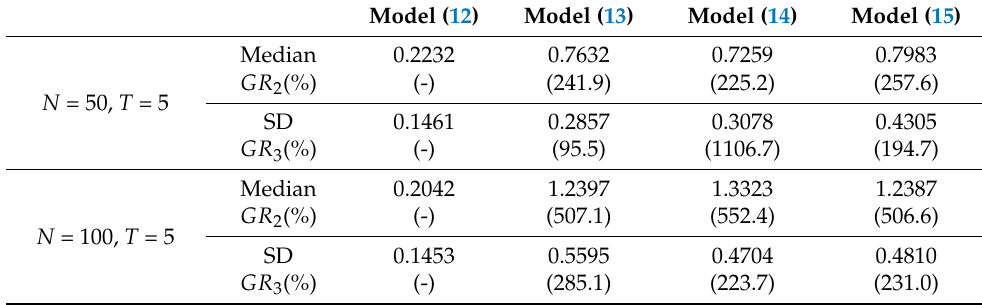
Table 6. The medians and SDs of MADEs for nonparametric estimates under the models (12)–(15).